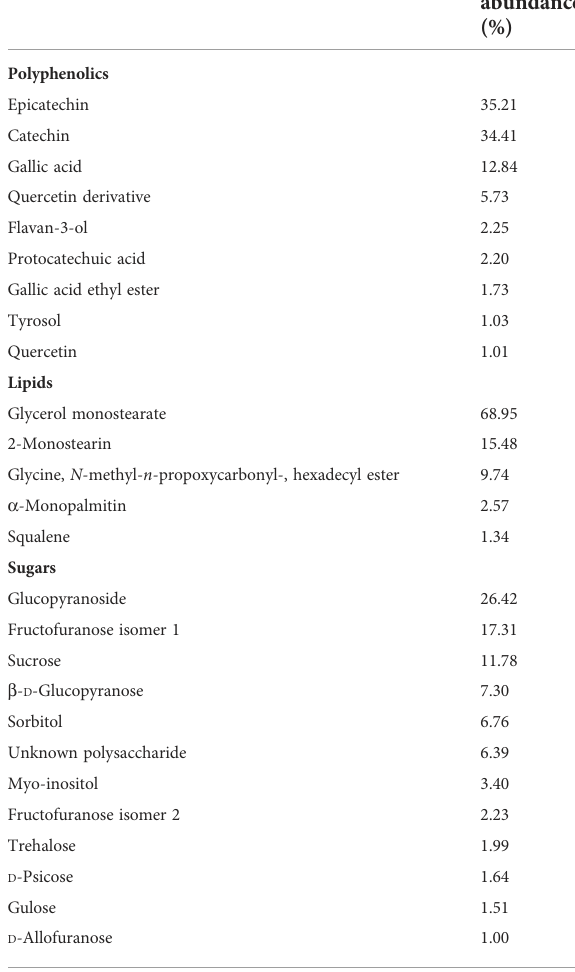
TABLE 2 GSE main